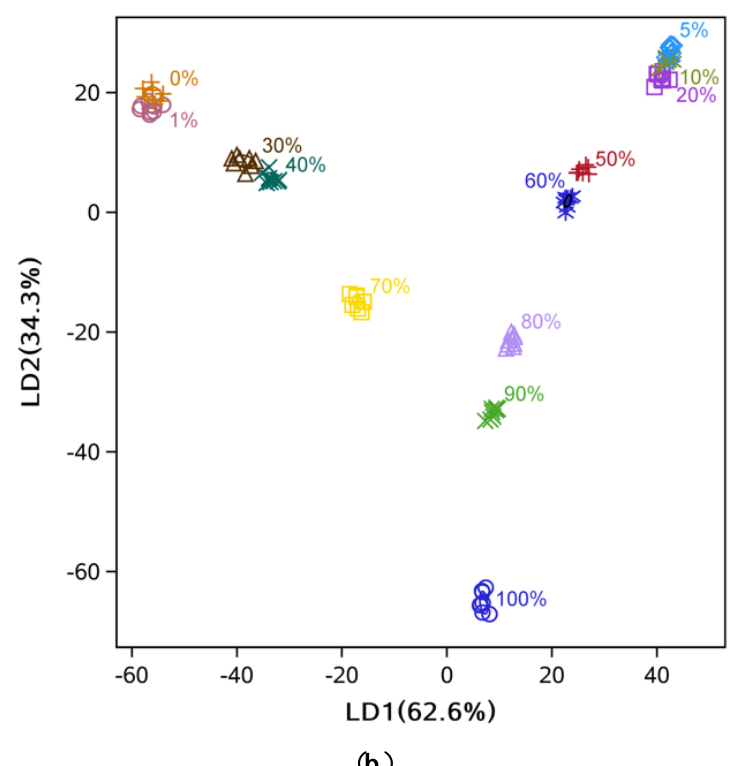
Figure 6. LD1 and LD2 score plot from LDA analysis. ( a ) Hot-pressed sesame oil mixed with refined sesame oil; ( b ) Cold-pressed sesame oil mixed with refined sesame